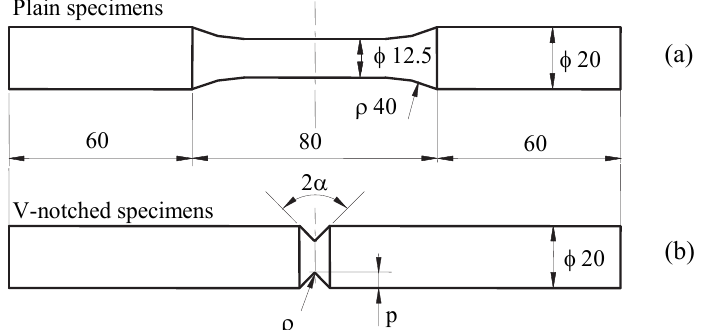
Figure 1: Geometry of plain (a) and notched (b) specimens used in the experimental